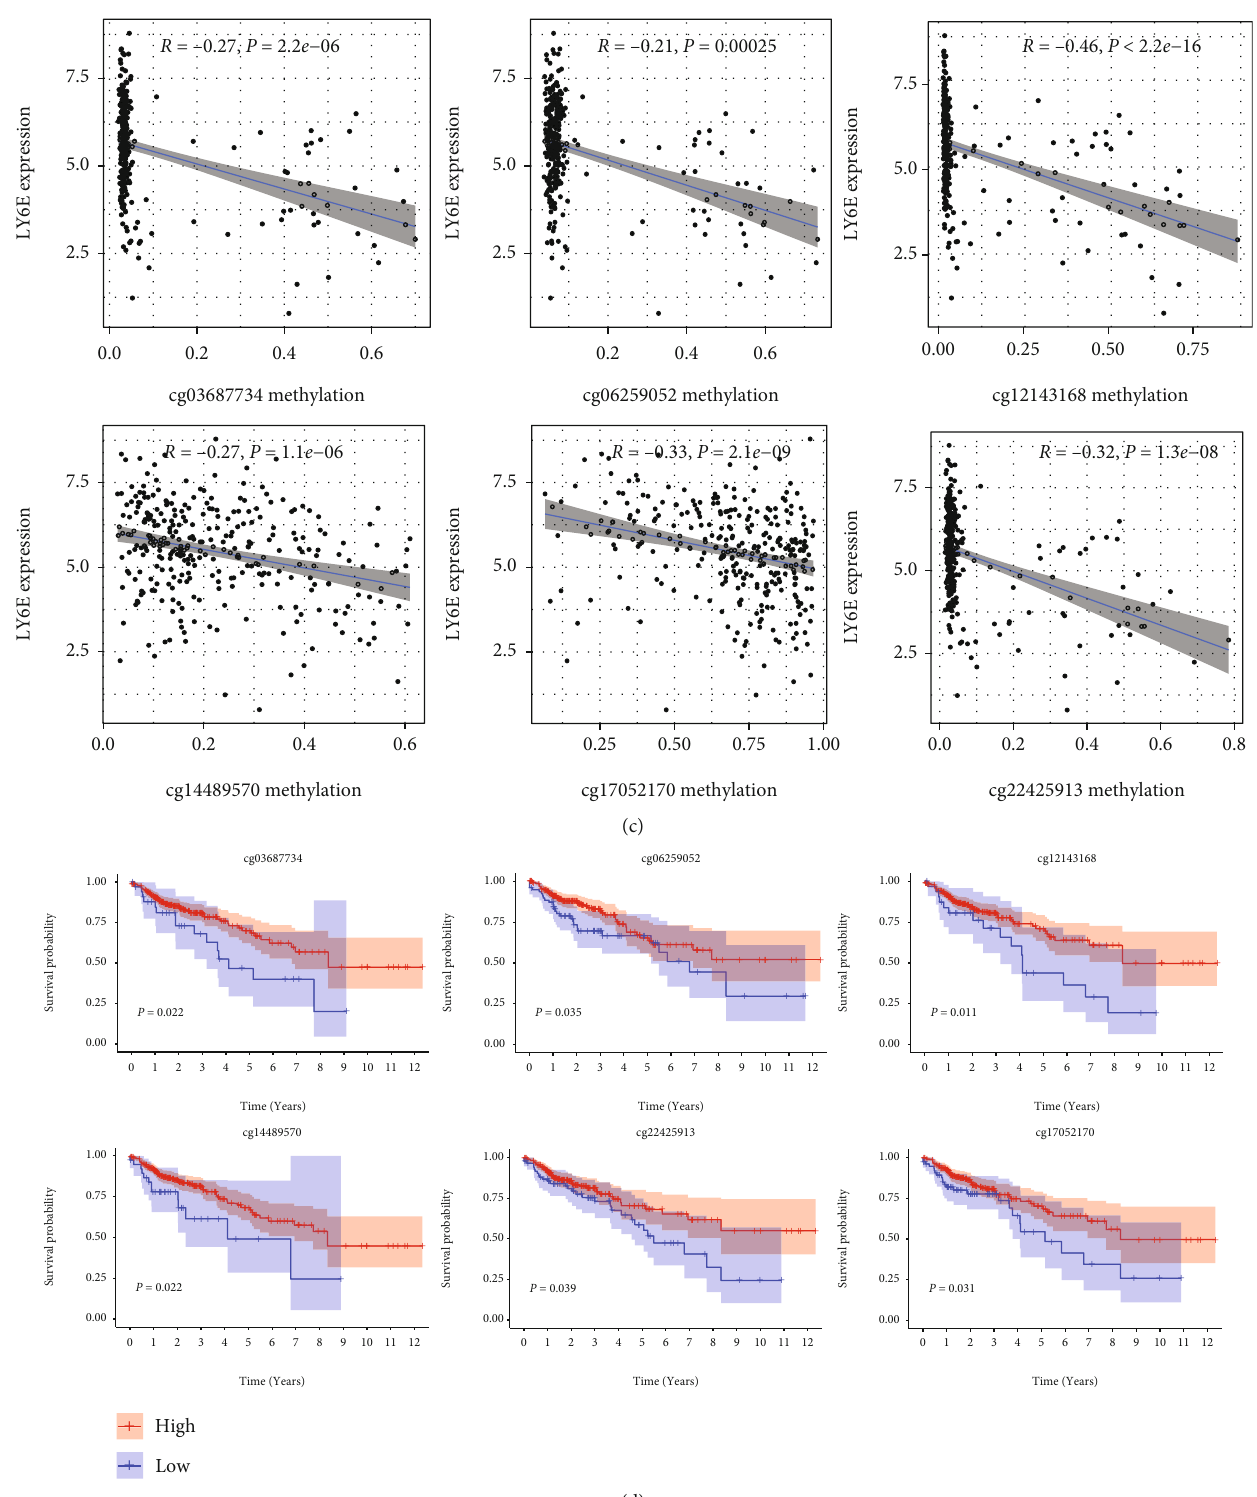
Figure 4: CRC survival-related CpG sites of LY6E. (a) Thirteen CpG sites in the promoter region of LY6E. (b) LY6E expression was negatively correlated with the mean methylation level of LY6E. (c) LY6E expression was negatively correlated with the methylation level at each promoter CpG site. (d) Six of these methylation sites were linked to a poorer overall